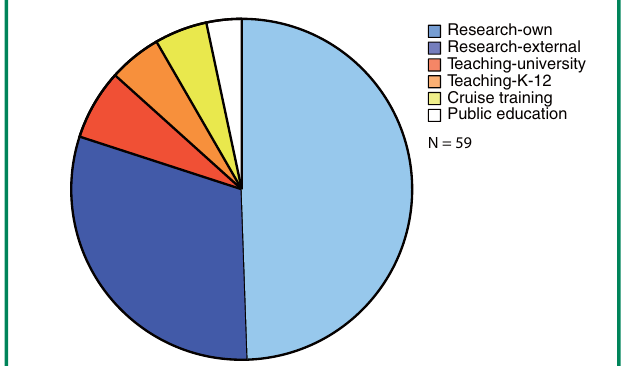
Figure 5. MRC usage in 2004, based on MRC curatorial